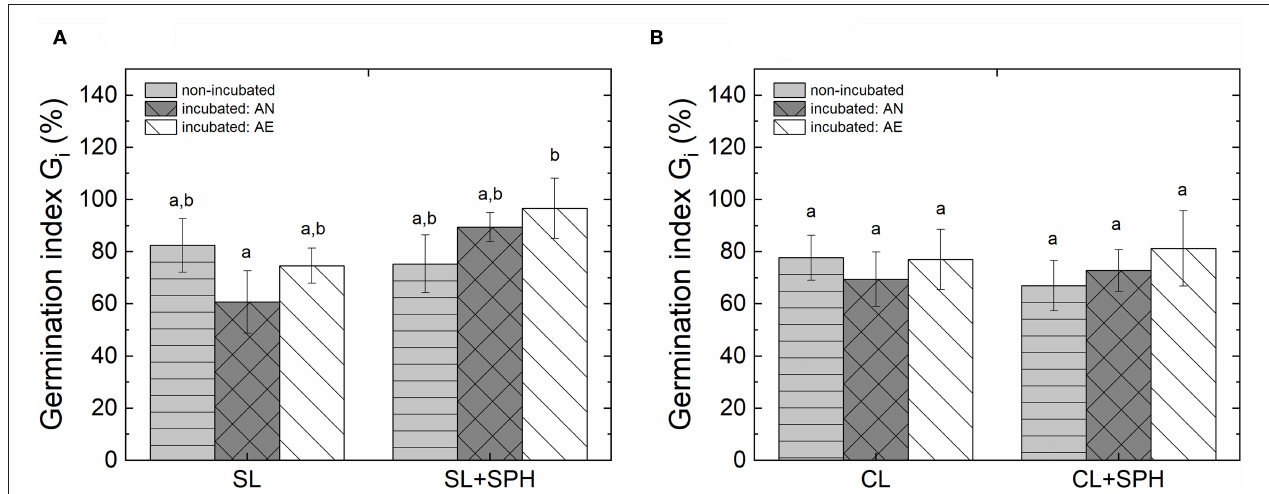
FIGURE 4 | Phytotoxicity of water extracts (Dilution rate: 1:1g dw/g water) for non-incubated and incubated (15 days) samples for two different soil types for radish seeds: (A) sandy loam, SL and (B) sandy clay loam, CL with (SPH, 2% dw) and without amended spent pollinator hulls under anaerobic (AN) and aerobic (AE) conditions. Different letters indicate significant differences in a one-way ANOVA followed by a Tukey’s HSD post-hoc test. Bars represent standard deviations (10 seeds, n =